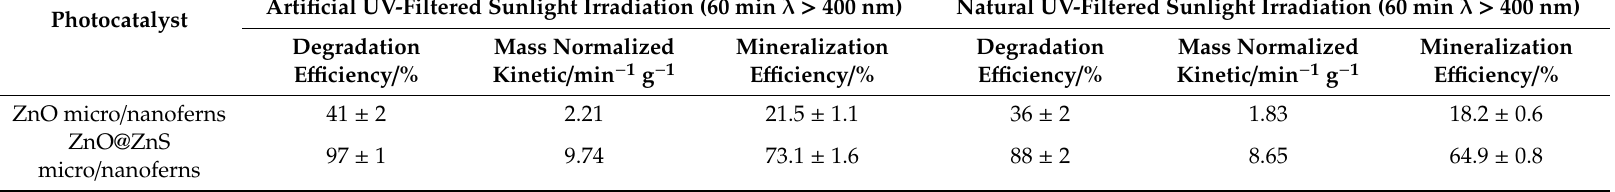
Table 2. Photocatalytic degradation e ffi ciency of MB (5 ppm) polluted saline solutions under artificial sunlight ( λ > 400 nm) and natural sunlight ( λ > 400 nm)